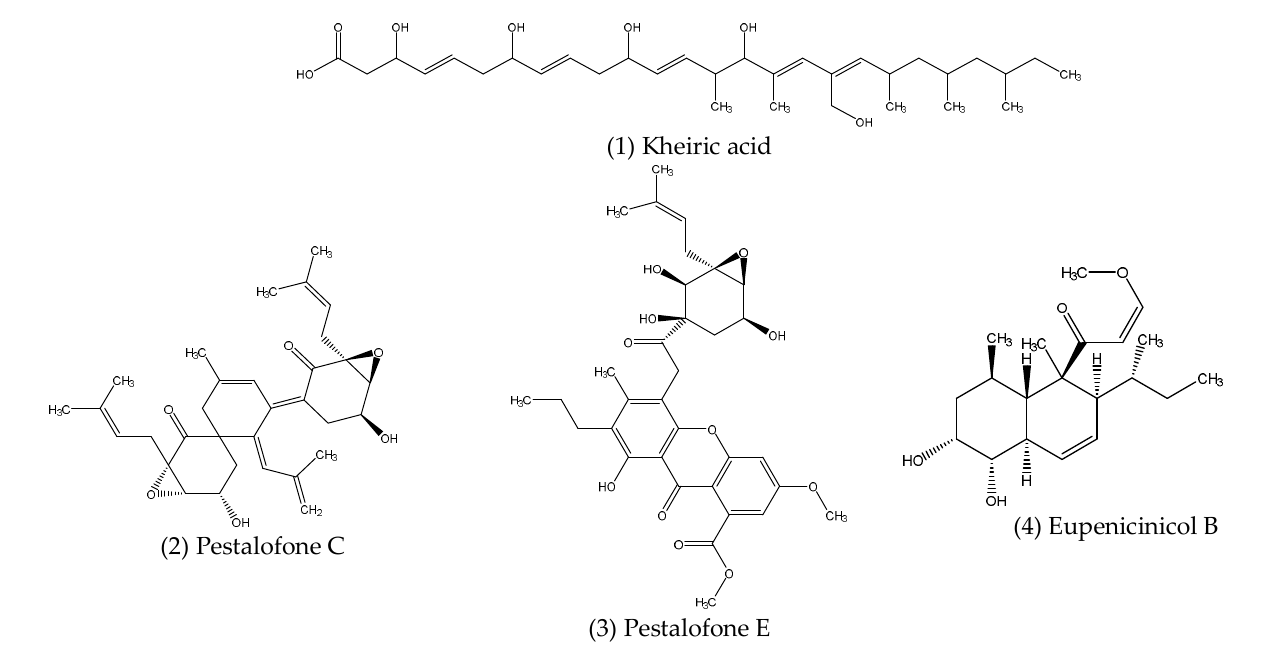
Figure 1. Structures of antimicrobial aliphatic compounds produced by endophytes.